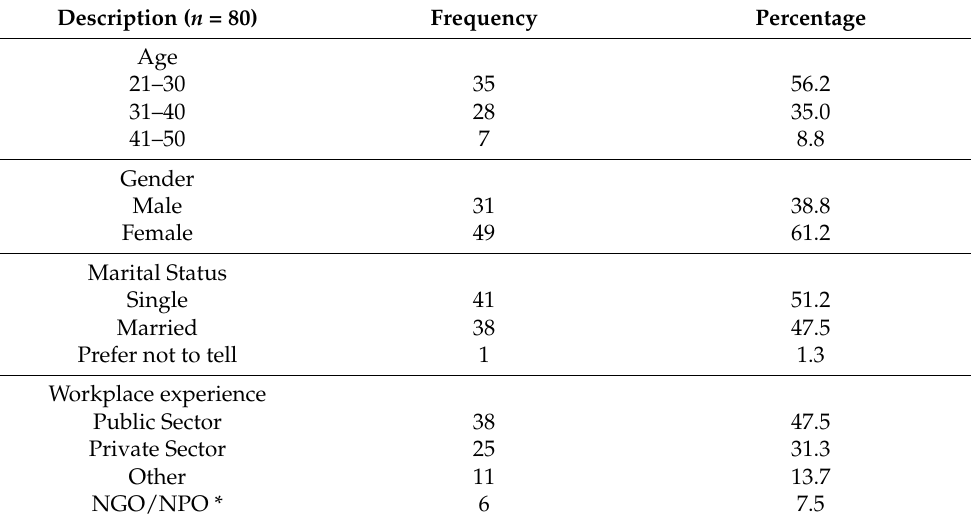
Table 1. Profile of respondents